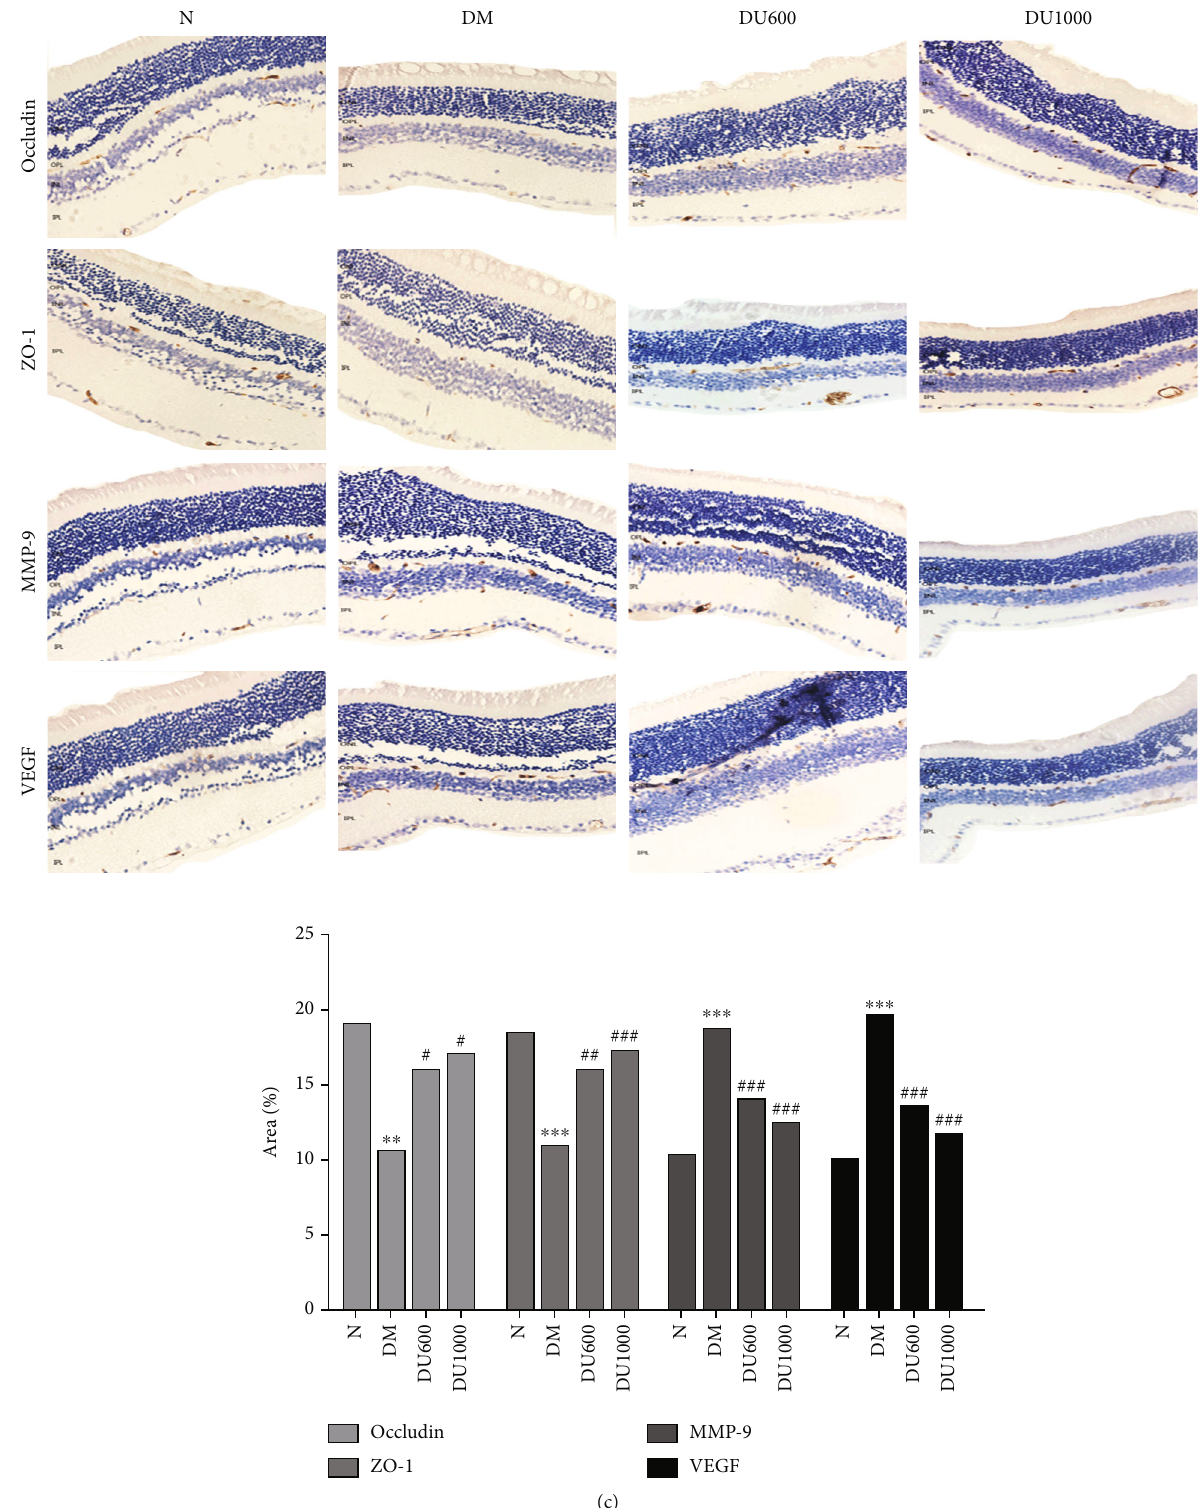
Figure 4: Reduction of albumin leakage and MMP-9/VEGF expression and increasing of ZO-1/Occludin expression through GLP-1RA treatment. (a) Western blot analysis of retinal albumin leakage in four groups. (b, c) Immuno fl uorescence and immunohistochemistry analysis of retinal MMP-9/VEGF/ZO-1/Occludin expression in four groups and histogram comparisons (40 × ). Annotation: compared with the normal group, ∗ p < 0 : 05 , ∗∗ p < 0 : 01 , and ∗∗∗ p < 0 : 001 ; compared with the DM group, # p < 0 : 05 , ## p < 0 : 01 , and ### p < 0 : 001